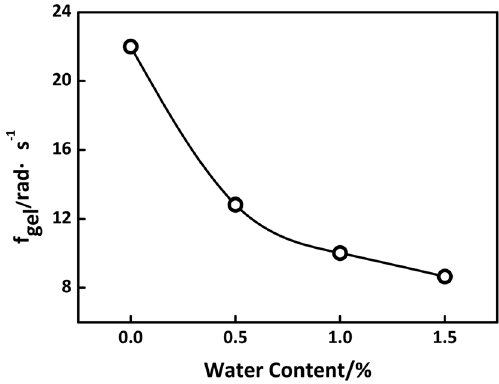
Figure 5: The gel transition frequency f gel of PAN solution versus water